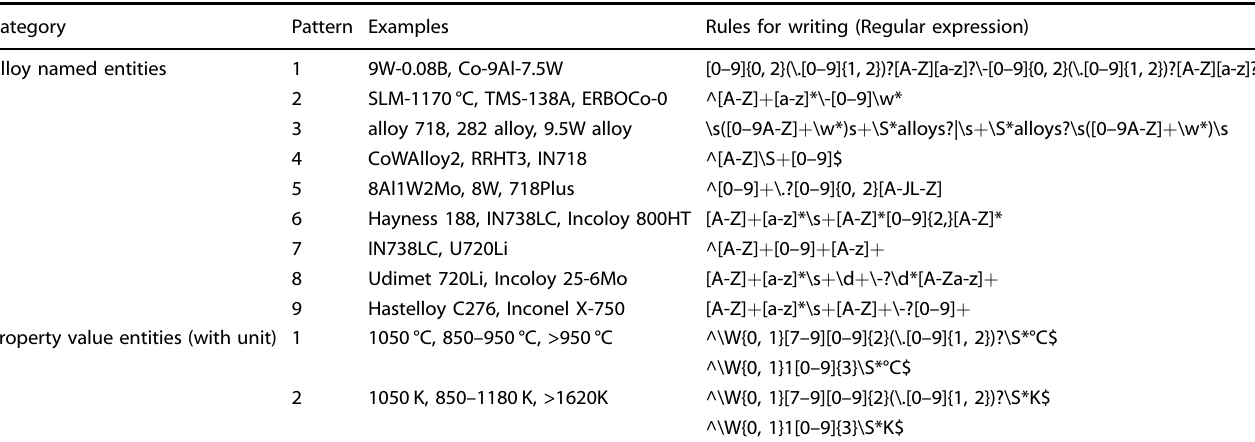
Table 1. In-domain word patterns, examples, and rules for writing alloy named entities and property value and unit.